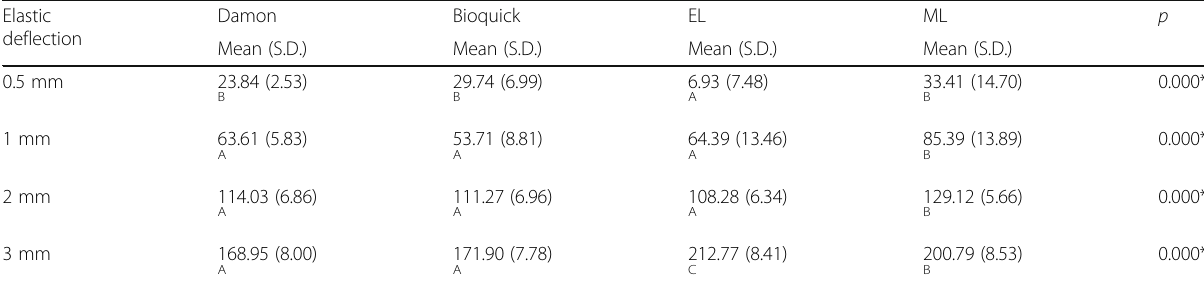
Table 4 Mean (in cN) and standard deviation (SD) of 0.014-in. thermally activated NiTi wires, in the bracket systems ( n = 10) Elastic deflection